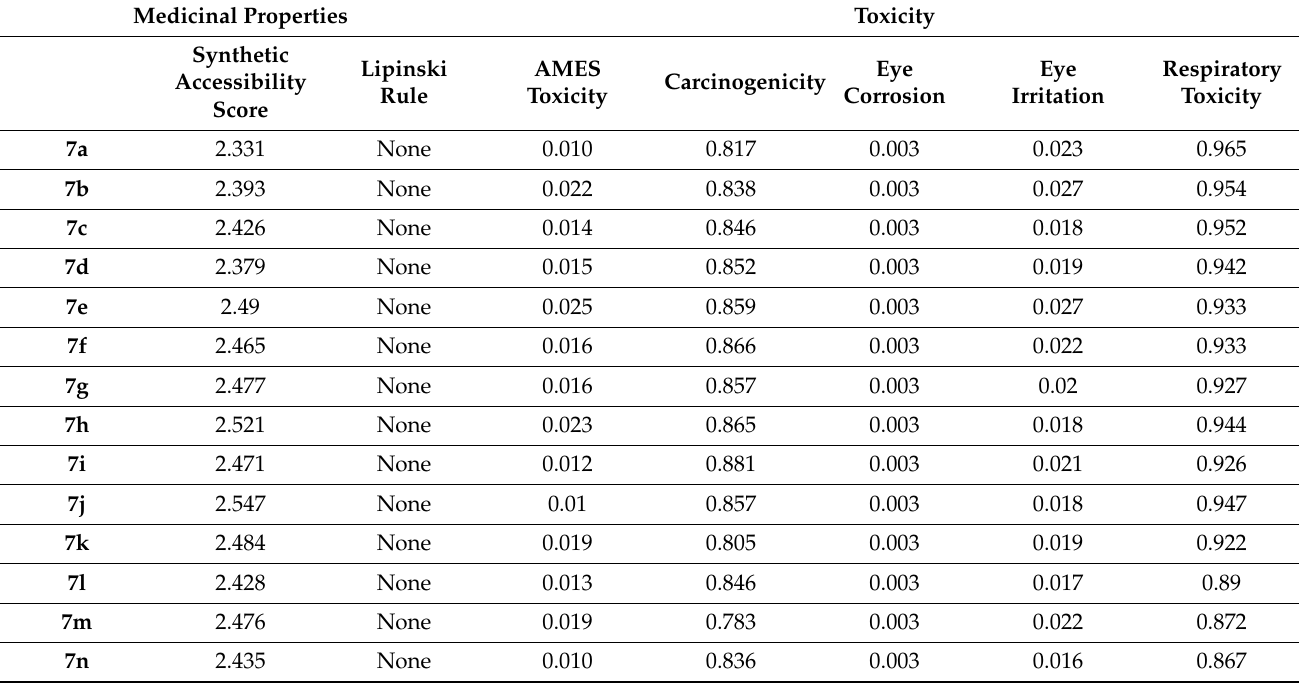
Table 9. Medicinal properties and toxicity profile of selected